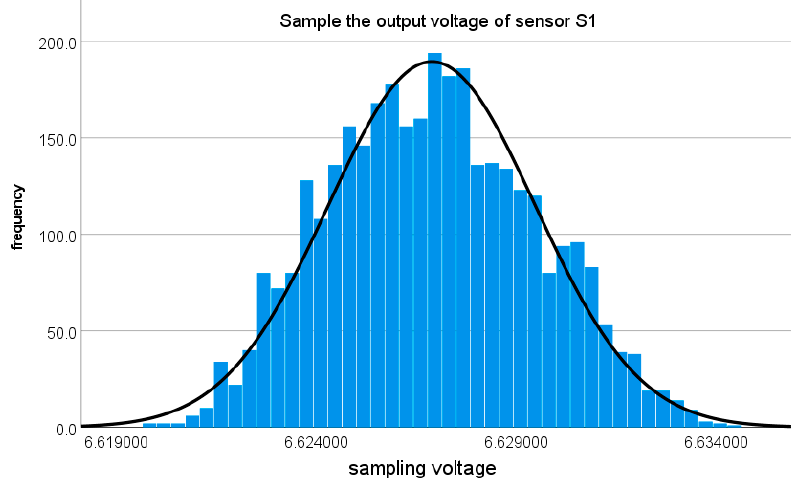
Figure 8. Histogram of the sensor S1 normality test.